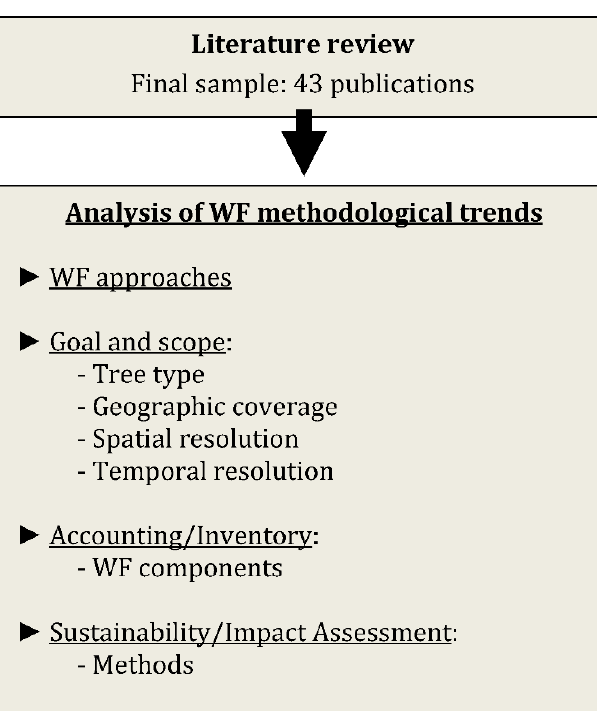
Figure 3. Methodological scheme followed in the present review.